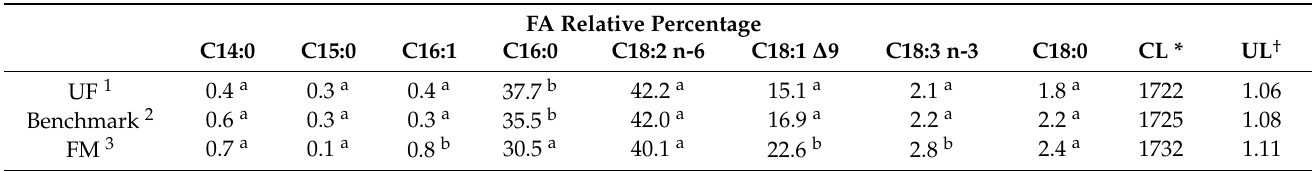
Table 4. Fatty acid profiles expressed as relative percentages, of each considered preferment (FM and benchmark) and unfermented milling by-product mixture (UF). For the same parameter, average values lacking a common letter ( a,b ) significantly differ from each other.